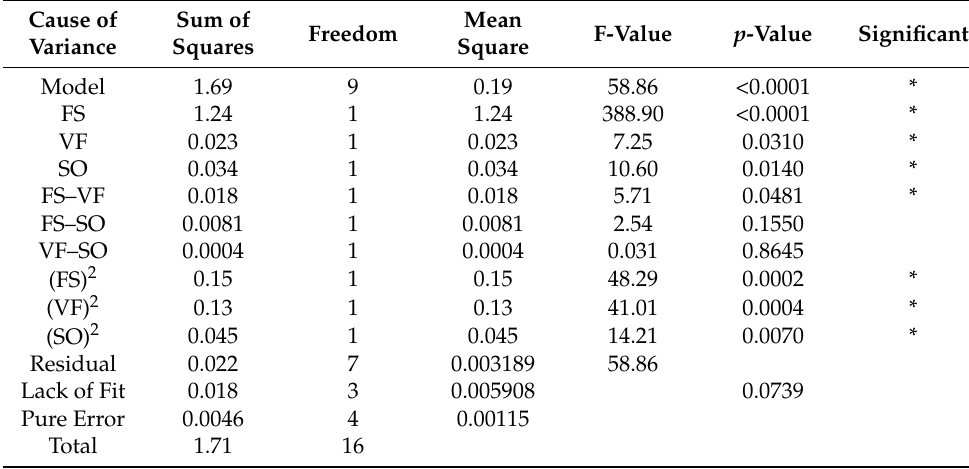
Table 10. ANOVA for the loss